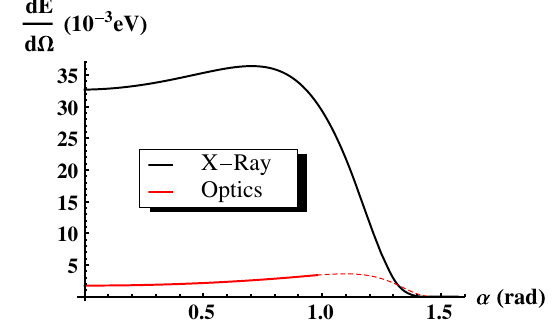
FIG. 11. Angular distribution of the fifth peak (fifth order) of SPR for optical region (red dashed curve) and for x-ray region (black curve). It is plotted using Eqs. (60) – (63) for optical region γ ¼ 1710 (energy of Mainz Microtron MAMI), d ¼ 9 μ m, h ¼ 127 μ m, ϕ ¼ 0 . 9 rad; and for x-ray region γ ¼ 4 × 10 4 (energy of SLAC), ℏ ω p ¼ 26 . 1 eV (beryllium), d ¼ 0 . 9 μ m, = ω 2 h ¼ 60 μ m, ϕ ¼ 0 . 3 rad, ε ð ω Þ ¼ 1 − ω 2 p m . For both of the curves N ¼ 20 , m ¼ 5 , a ¼ d= 2 , θ ¼ arccos ð β − 1 sin α Þ . The dashed line corresponds to the angles breaking the inequality ω < ω 2 π c= ω 380 for λ m optical optical ¼ optical ¼